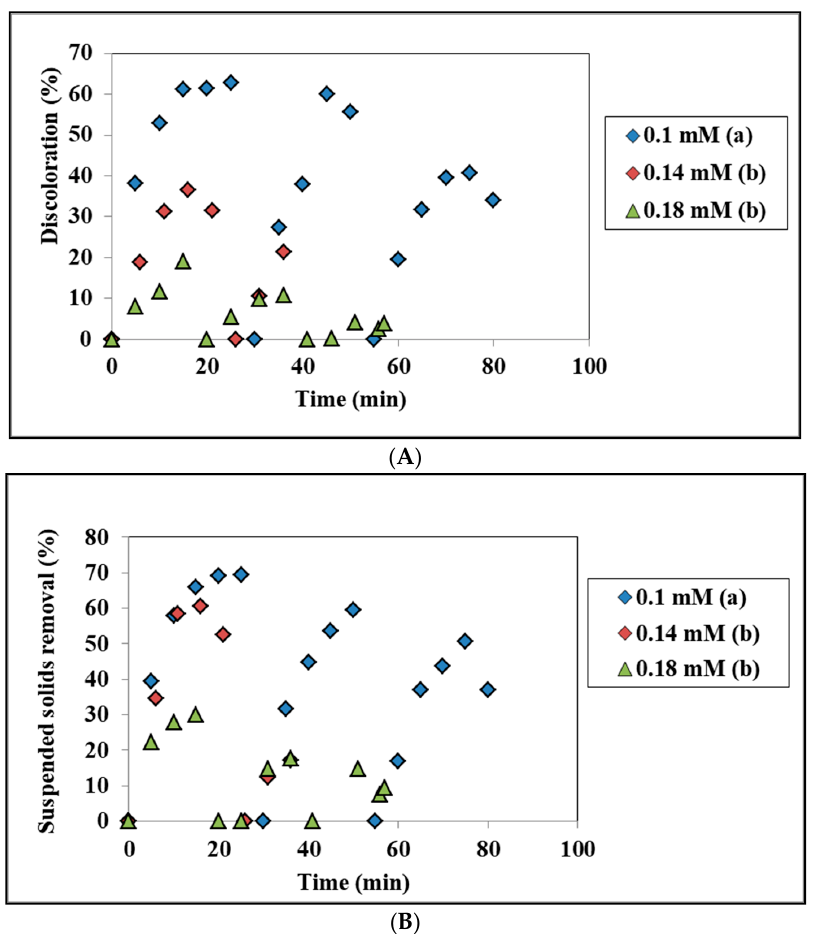
Figure 8. ( A ) FeSO 4 concentration influence on WW discoloration. (a) 17 L/h, 100 rpm; (b) 20 L/h, 200 rpm. Initial operating conditions: C 0,H2O2 = 24.86 mM; pH = 4.10. ( B ) FeSO 4 concentration influence on suspended solids removal. (a) 17 L/h, 100 rpm; (b) 20 L/h, 200 rpm. Initial operating conditions: C 0,H2O2 = 24.86 mM; pH =